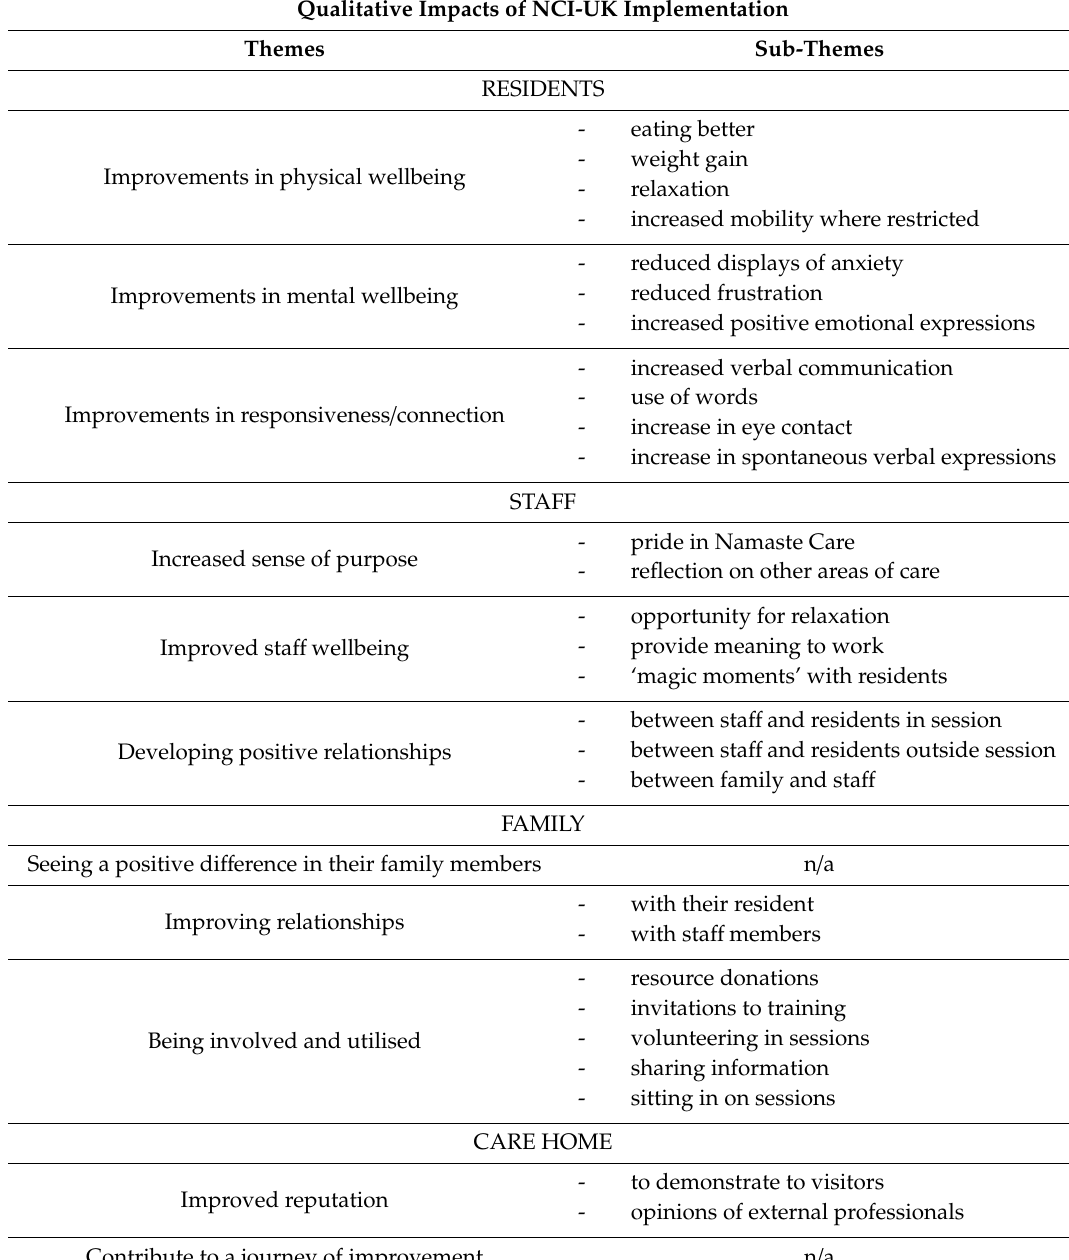
Table 10. Summary of qualitative impacts of NCI-UK implementation for all a ff ected